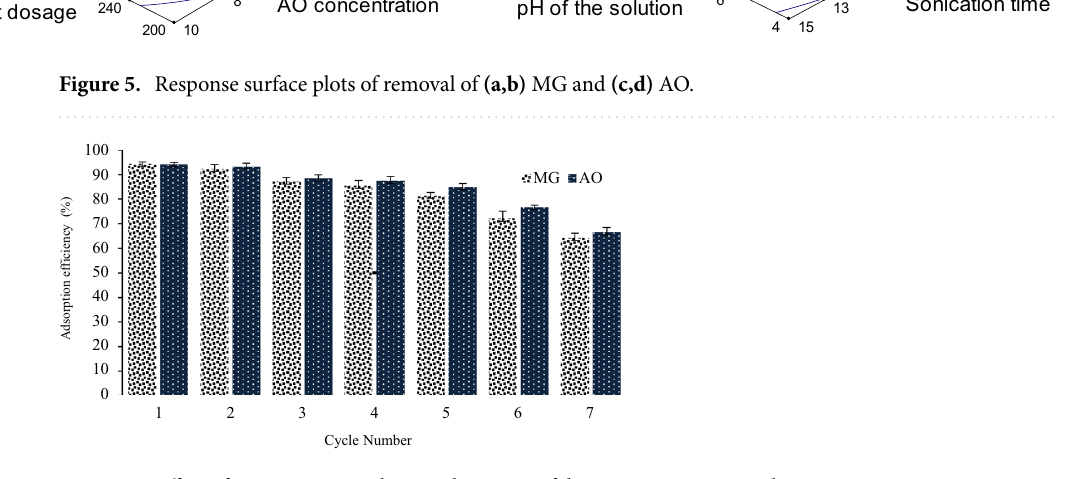
Figure 6. Effect of regeneration cycles on adsorption of dyes onto NaX